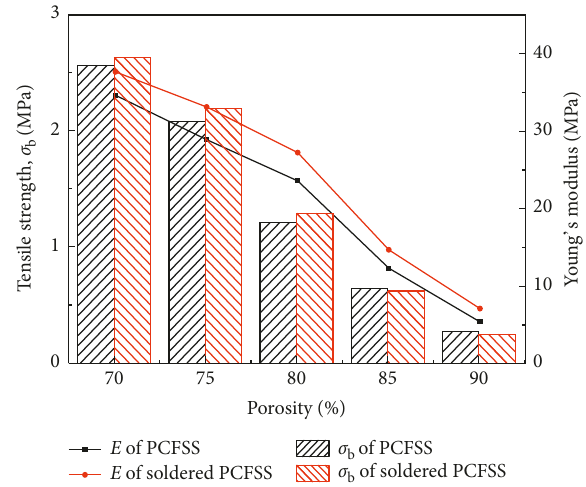
Figure 10: Comparison of the tensile properties of PCFSSs with homogeneous porosity and soldered PCFSSs with the same porosity.